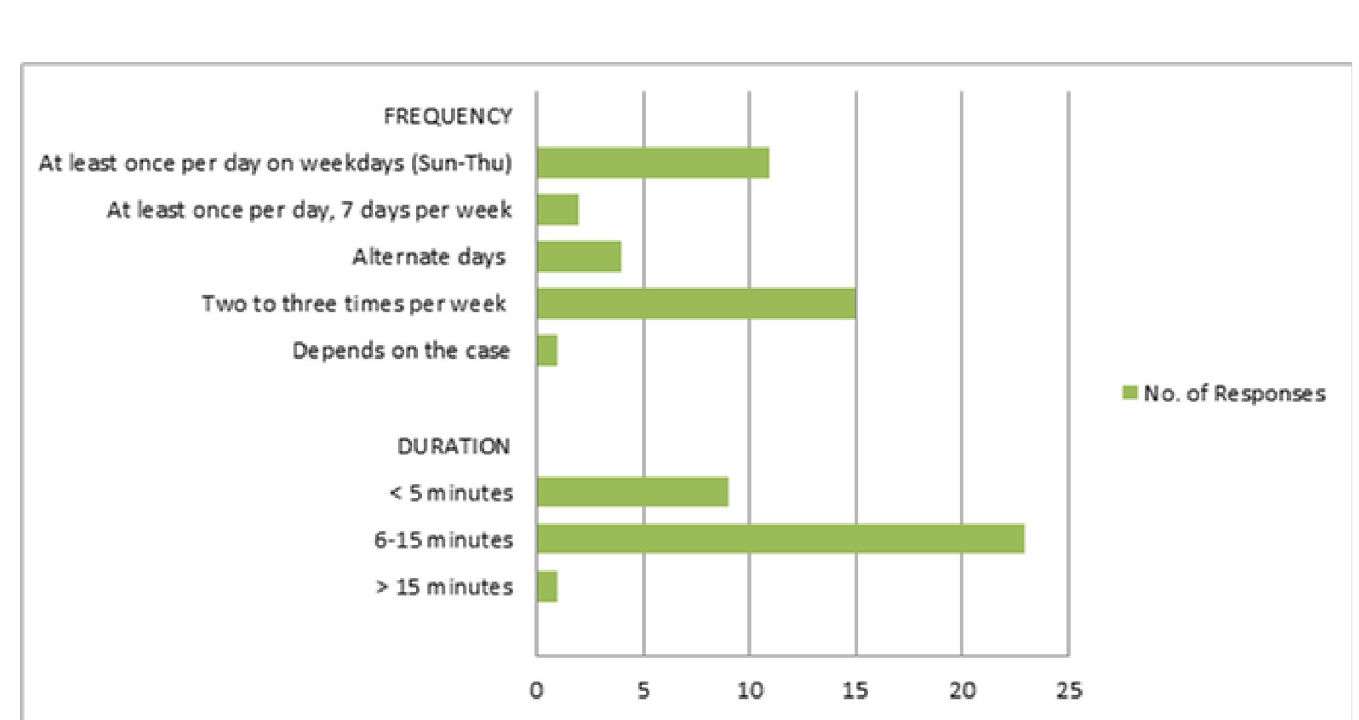
Fig 2. Frequency and duration of performing passive range of motion assessment reported by the 33 respondents.